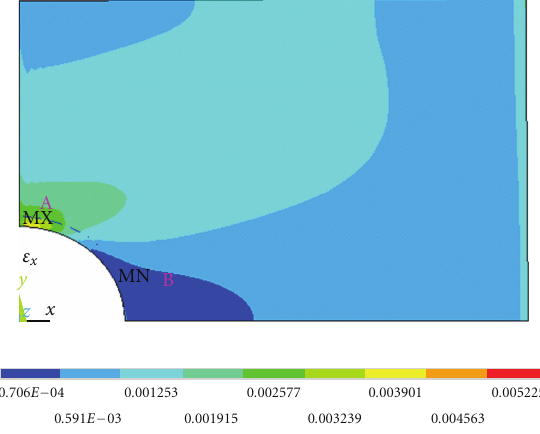
Figure 11: ε x distribution of the single-line stitching model.